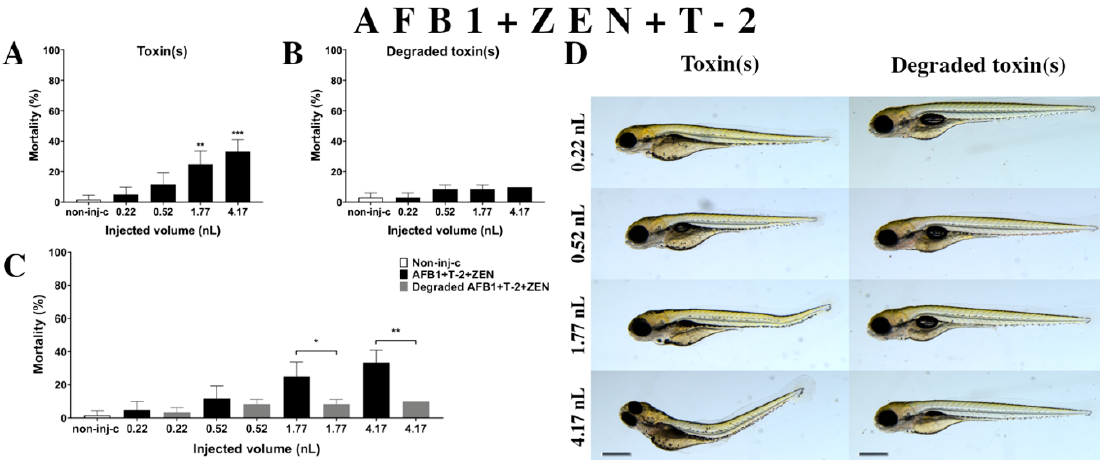
Figure 8. Effects of AFB1+ZEN+T-2 mixture ( A ) and their degradation products ( B ) by the Rhodococcus erythropolis NI1 strain